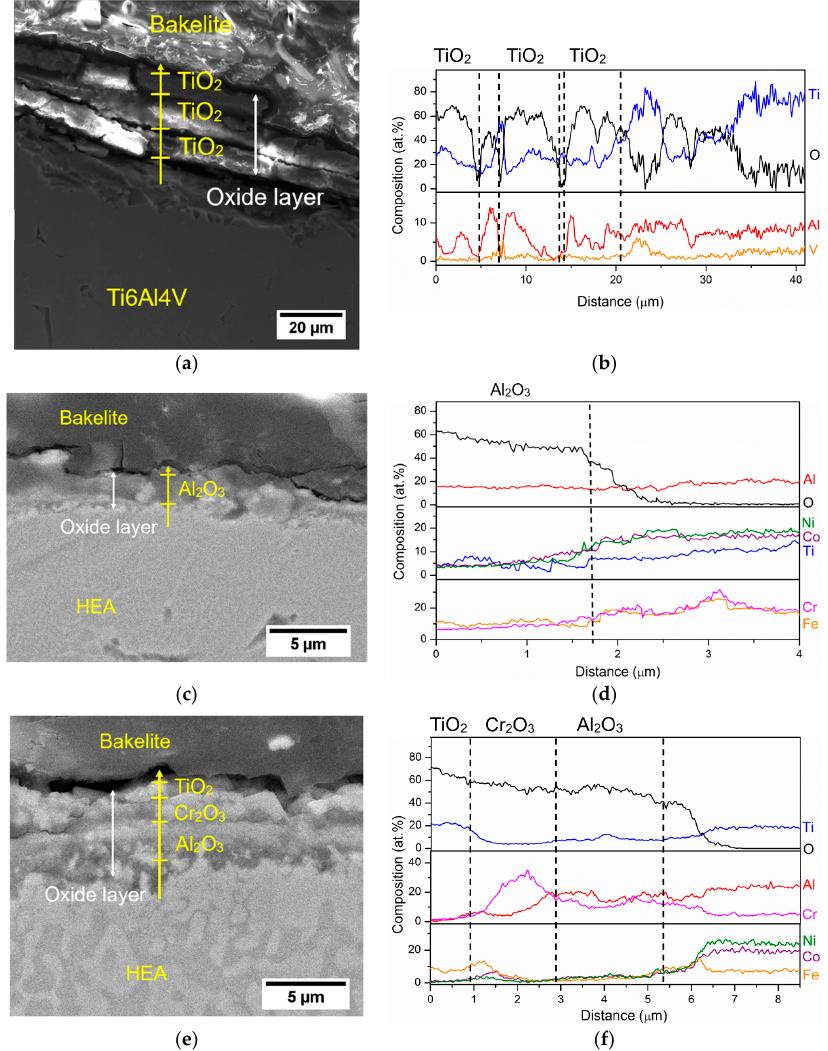
Figure 9. Cross-sectional backscattered electron images and the corresponding elemental composition distribution along the yellow arrow for the oxidized: ( a ) and ( b ) Ti6Al4V at 700 ◦ C, ( c ) and ( d ) HEA at 700 ◦ C, ( e ) and ( f ) HEA at 800 ◦ C for 45